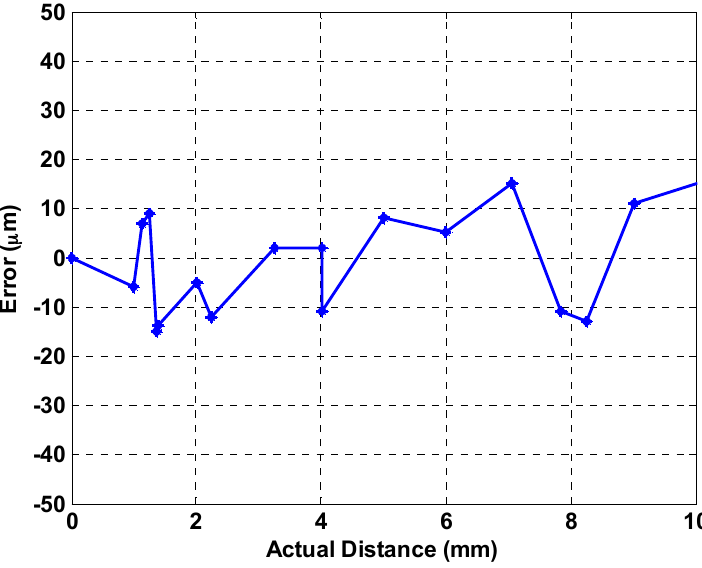
Figure 16. The spectrum analysis result of the 12-bit ADC output.